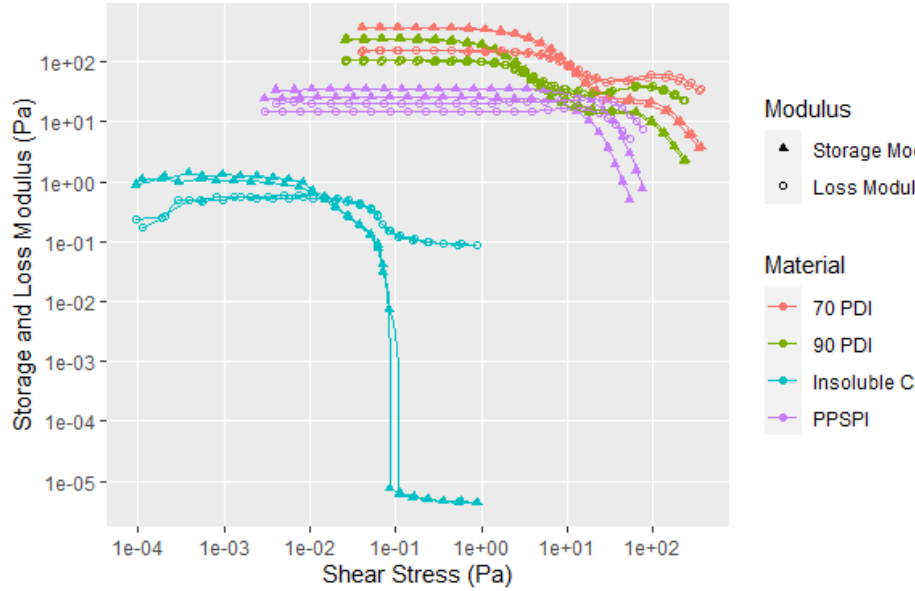
Figure A6. All replicates for the samples shown in Figure 7.